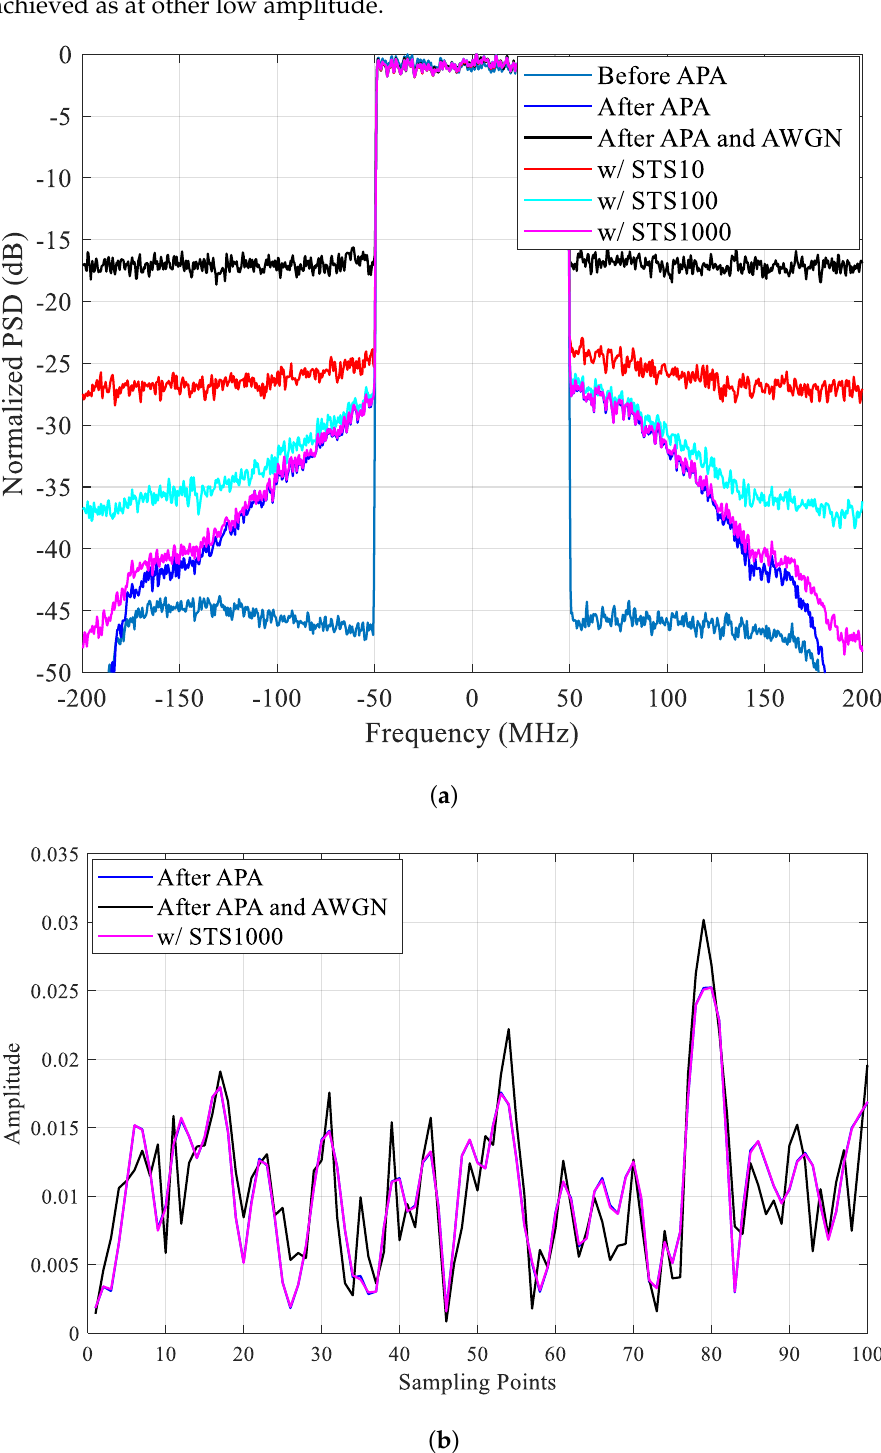
Figure 11. Frequency and time domain noise reduction results with STS method: ( a ) frequency domain; ( b ) Time